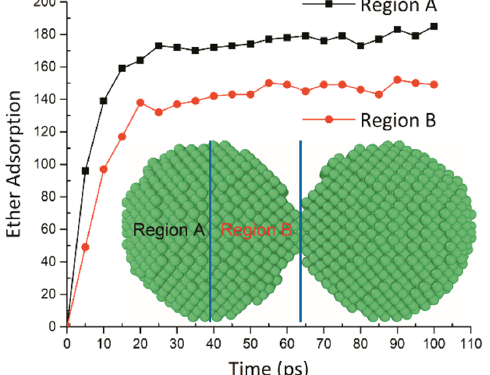
Figure 15. Adsorption curves and snapshot of different regions of double sphere model.